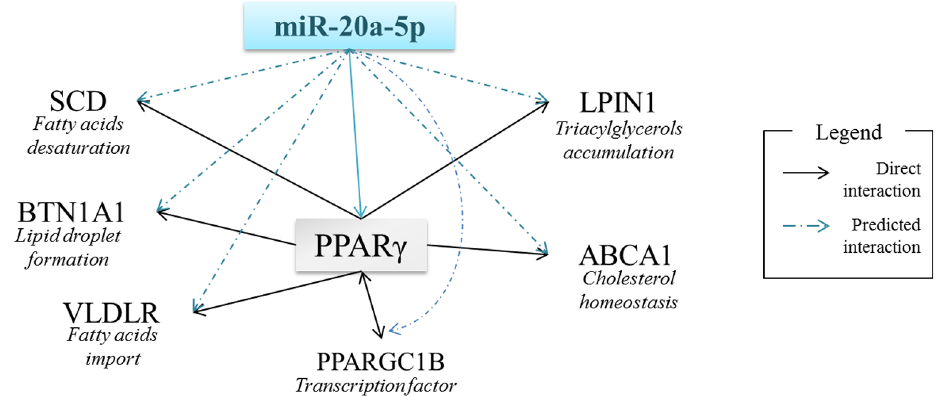
Fig 3. Potential regulations through miR-20a-5p in milk fat metabolism. ABCA1: ATP-Binding Cassette subfamilyA (ABC1) member1, BTN1A1: BuTyrophiliNsubfamily 1, member A1, LPIN1: LiPIN1, PPAR γ : Peroxisome Proliferator-Activated Receptorgamma, PPARGC1B: Peroxisome Proliferator-Activated Receptor Gamma Coactivator 1 Beta, SCD: Steroyl-CoA Desaturase,VLDLR: Very Low Density Lipoprotein LipaseReceptor.